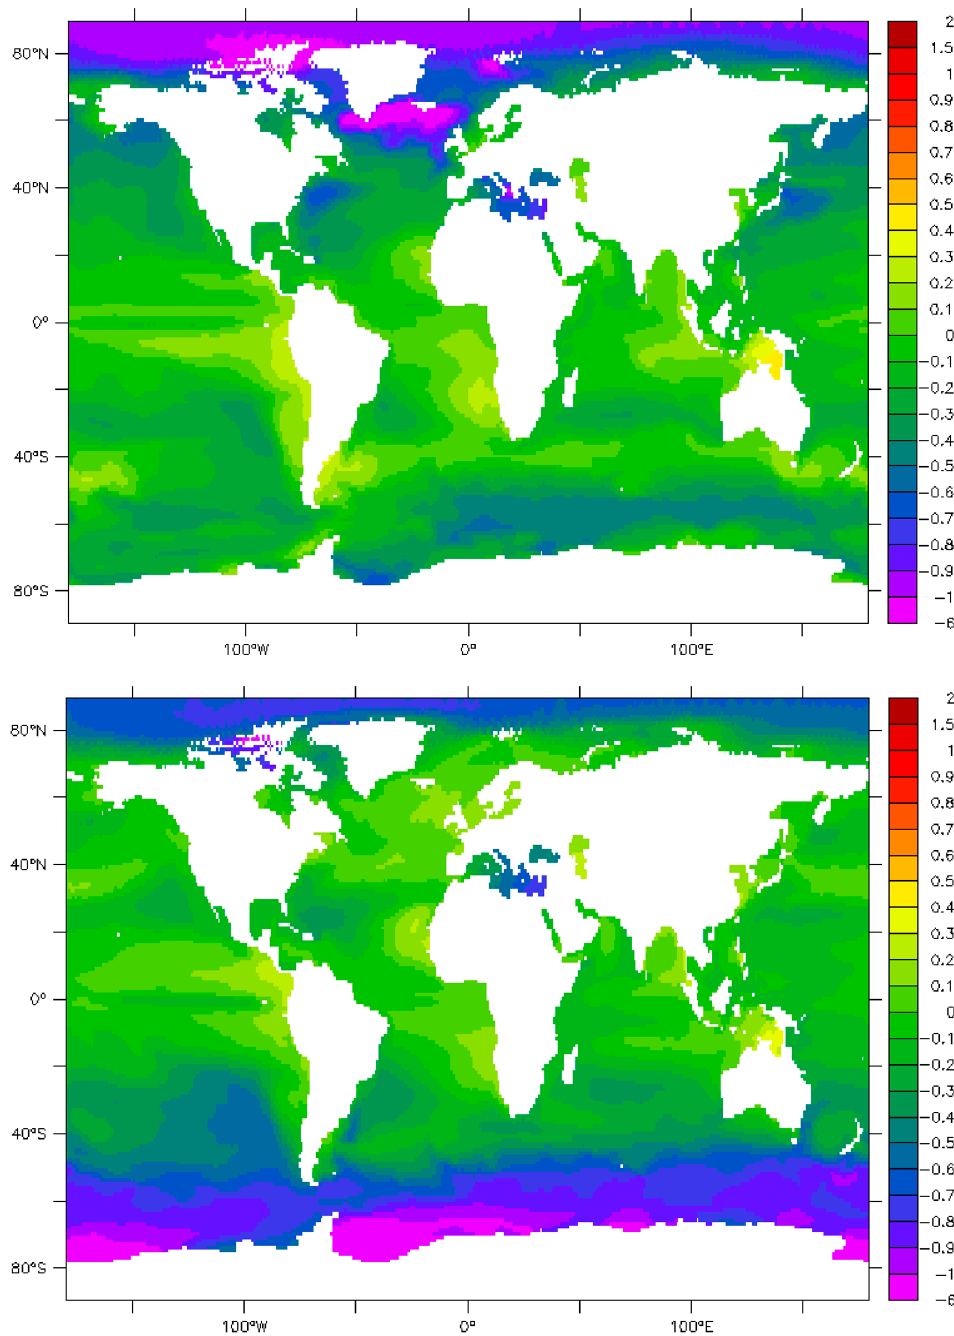
Figure 4. Log surface pressure maps ( Δ tension) constructed as in Figure 2 so that albumin is cut by three relative to the baseline, but with lipid levels zeroed. The color bar has been set so that a reference range of 0.3–3 mN/m is central ( − 0.5 to 0.5 in log units). February and August monthly averages are shown for a typical year near the turn of the millennium.